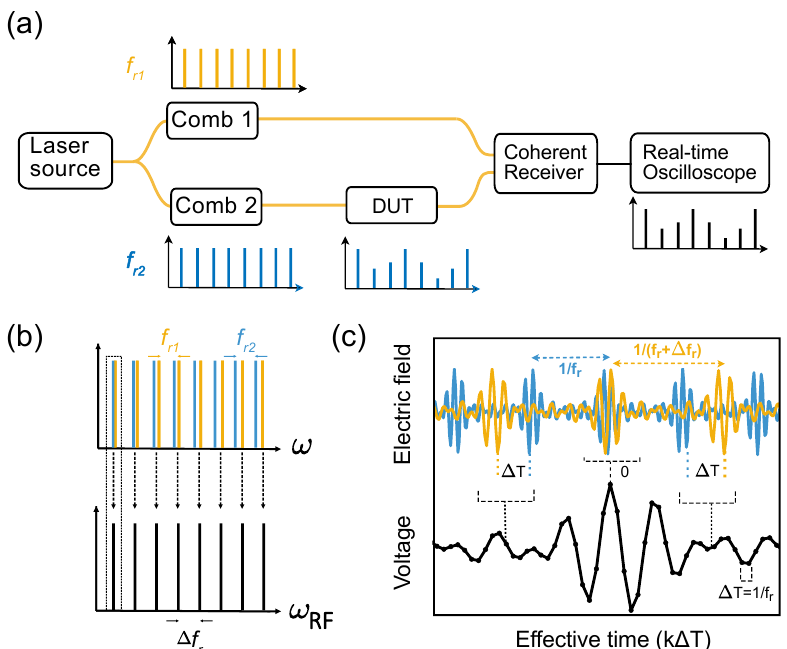
Figure 8. Frequency domain description of DCI: ( a , b ) Two frequency combs with slightly different repetition rates, f r 1 and f r 2 , interact with each other and at least one comb passes through the DUT, whose frequency response changes the shape of the comb lines. The resulting absorption and phase on the comb teeth are modified into the corresponding amplitude and phase of the measured RF comb (green) with the repetition frequency f r 2 − f r 1 = ∆ f r . The RF spectrum can also be obtained by Fourier transforming a series of time domain interferograms. Time domain description of DCI: ( c ) Two pulse trains with slightly different repetition rates, f r and f r + ∆ f r , beat each other in a photodetector. These two optical pulse trains interact and effectively ‘walk through’ each other. The resulting photoreceiver signal below is a product of two comb pulses integrated over the receiver bandwidth and the signal can be viewed as an interferogram. This output is usually a function of the effective time, k ∆ T , where k is the sample number at time intervals of ∆ T . The large central part of the received interferogram corresponds to the simultaneous arrival of the two pulses (when ∆ T is 0). A weak ringing visible on the ‘tails’ contains absorption information of the